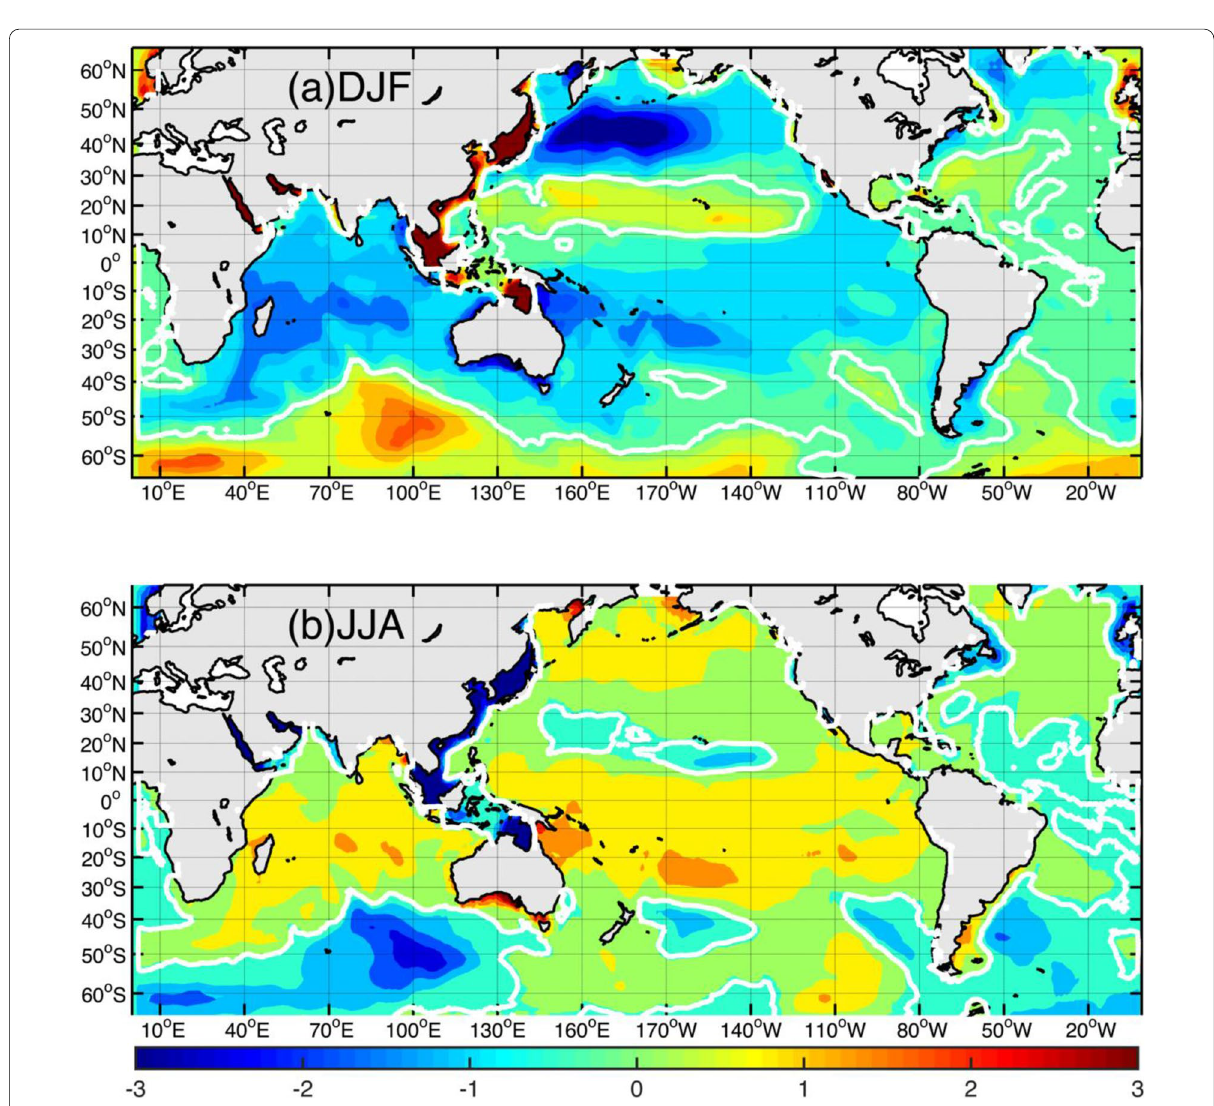
Fig. 4 Simulated ocean bottom pressure anomalies (cm) from PCOM Exp. 1 during boreal winter and